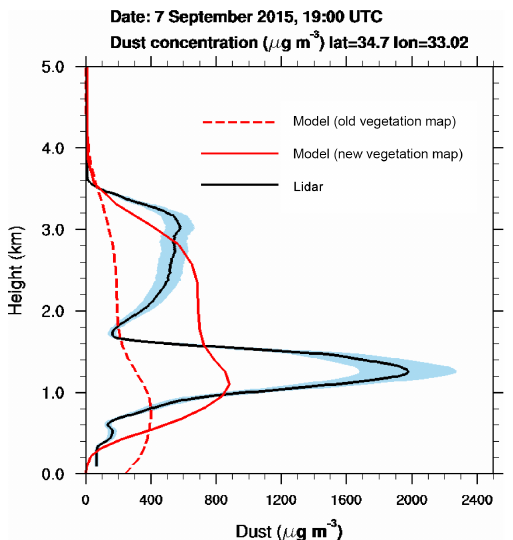
Figure 11. Vertical profile of dust concentration over Limassol on 7 September, 19:00UTC. The blue shadow indicates a 20% uncer- tainty in the lidar